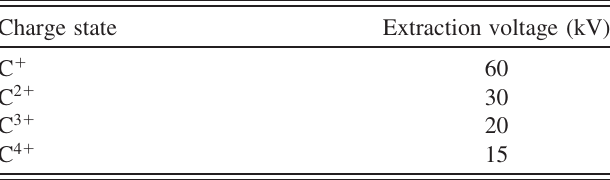
TABLE XIII. The extraction voltage for each carbon charge state for a two-beam IH-RFQ linac.